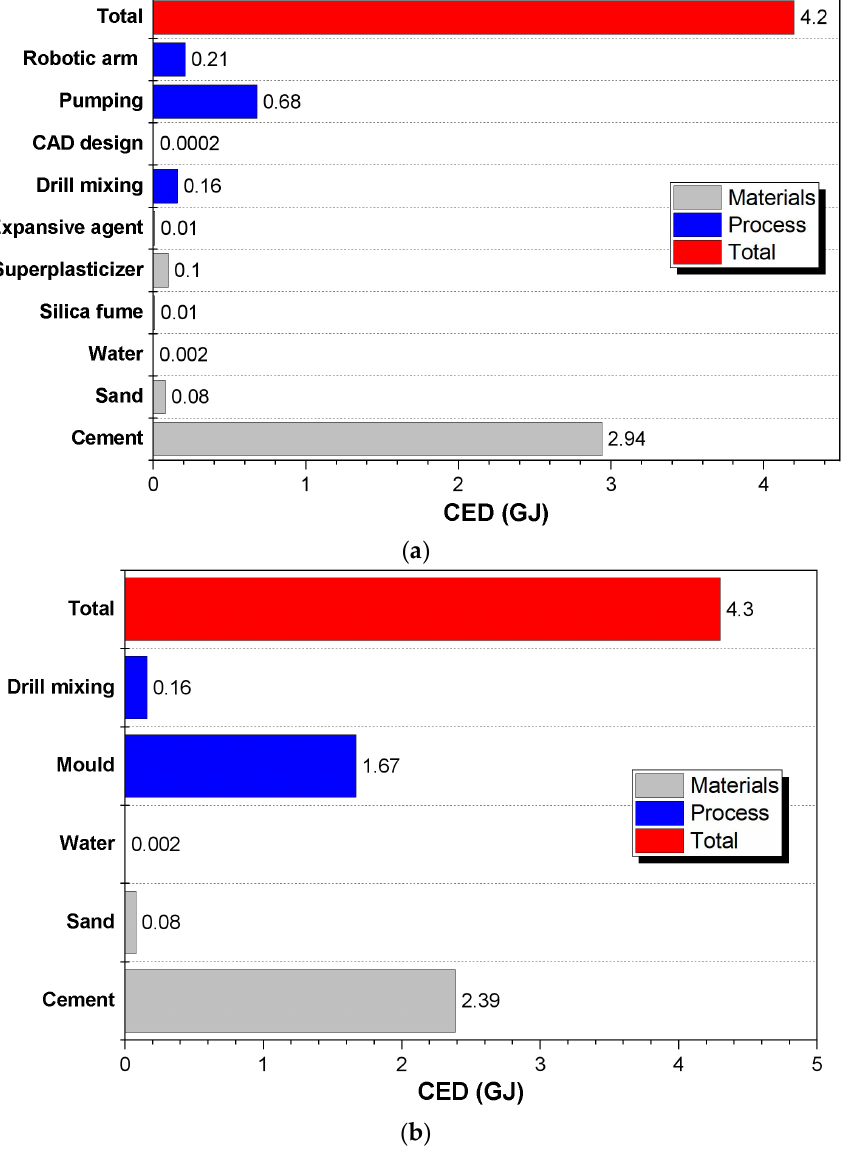
Figure 4. CED results: ( a ) p-CTR and ( b ) c-CTR .